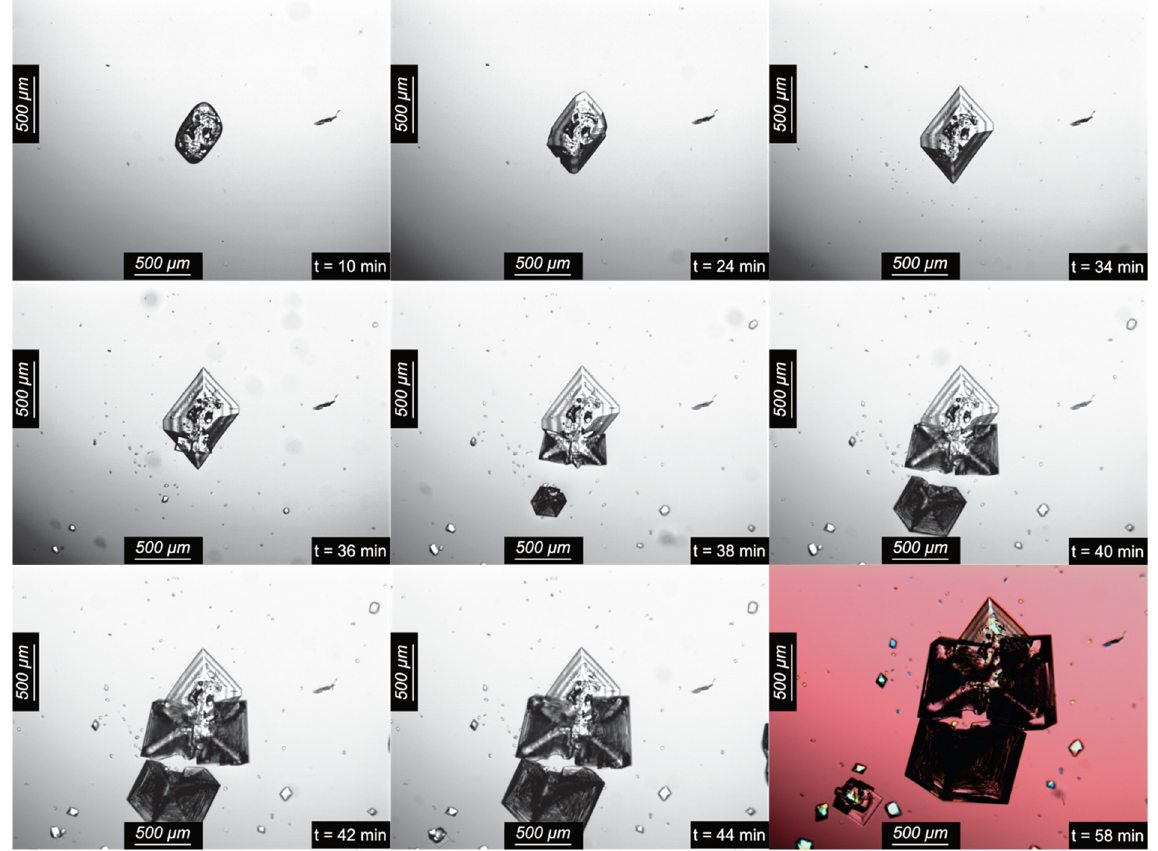
Figure 9. Optical photomicrographs along time of the NaCl–Na 2 SO 4 –H 2 O droplet under evaporation seeded with Na 2 SO 4 .